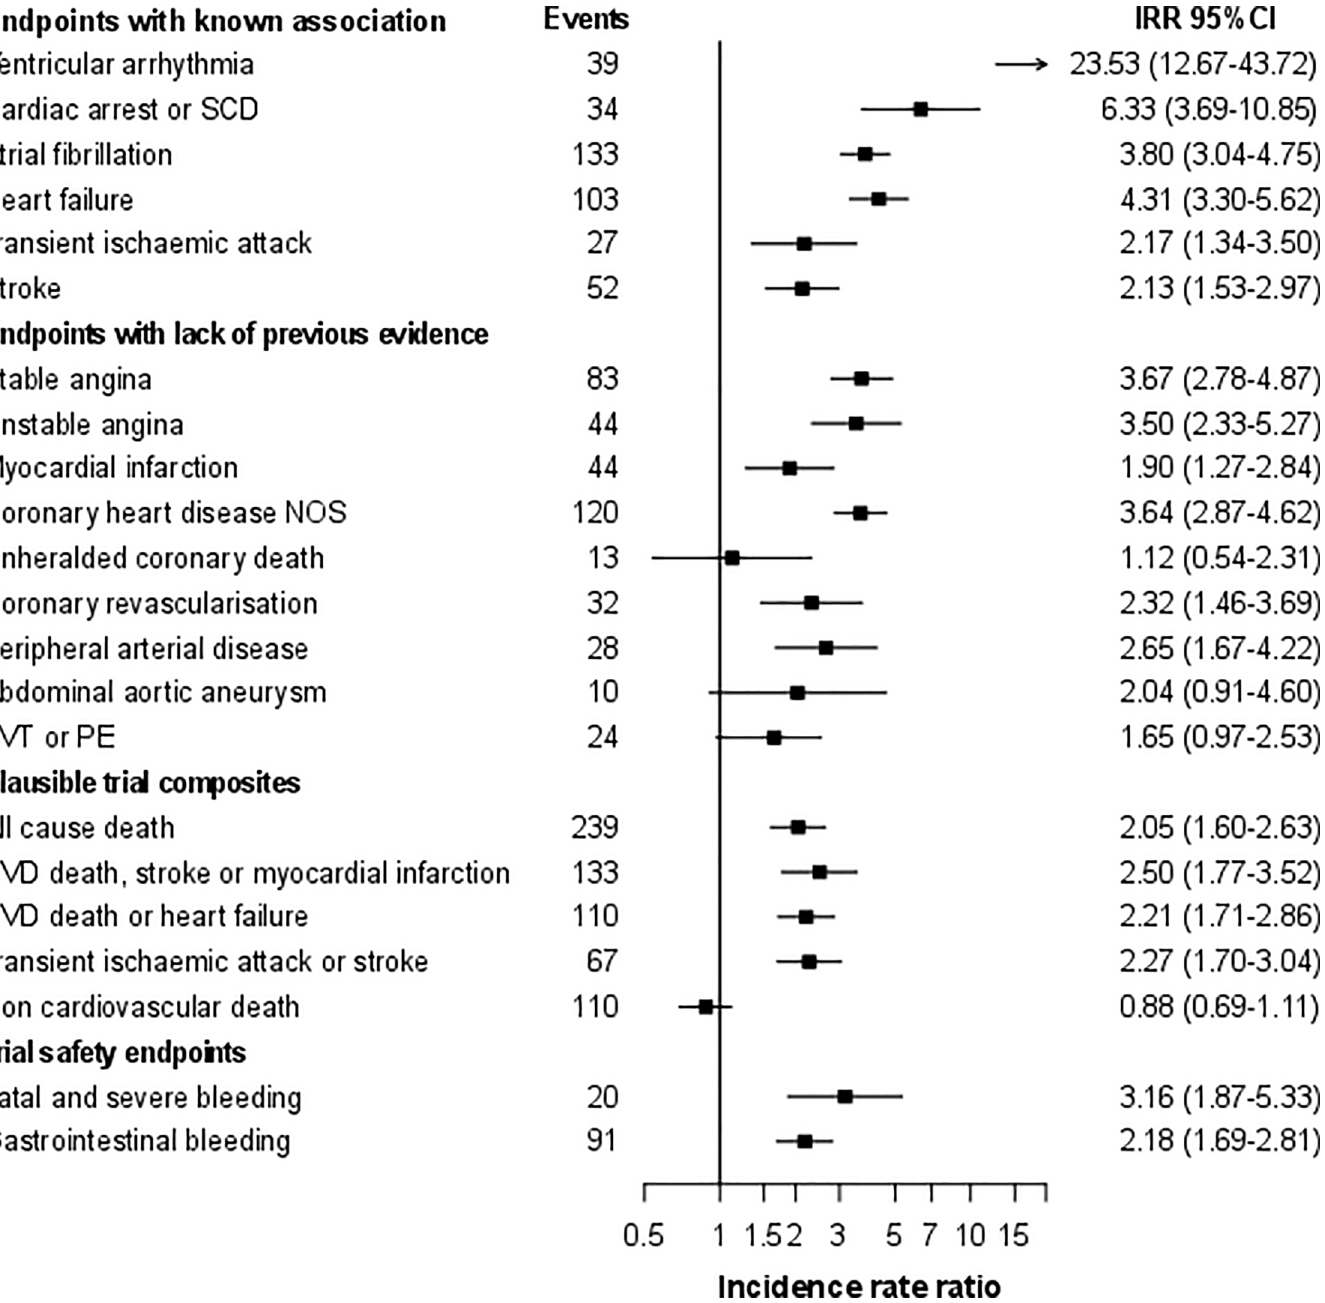
Fig 3. Relative risks (95% CI) of fatal and non-fatal clinically relevant and trial safety endpoints in a national sample of people with hypertrophic cardiomyopathy (vs. no hypertrophic cardiomyopathy). [Fig note: CI, confidence interval; DVT, deep vein thrombosis; MI, myocardial infarction; IRR, incidence rate ratios from random effects Poisson models adjusted for age, sex, index of multiple deprivation, smoking status, diabetes and systolic blood pressure; PE, pulmonary embolism; SCD, sudden cardiac